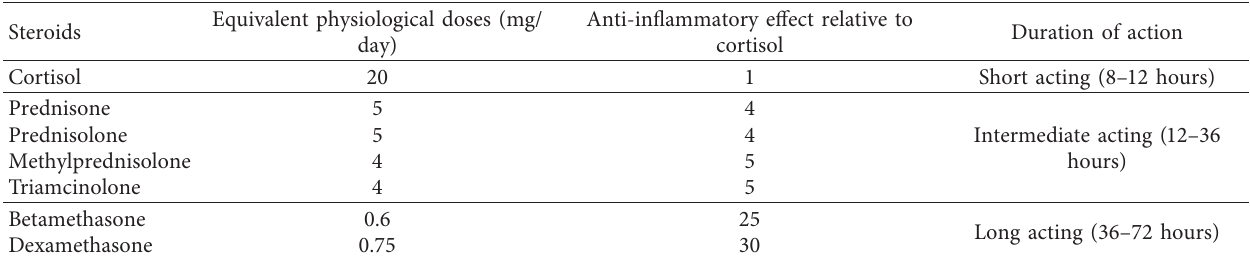
Table 3: Characteristics of commonly used steroids